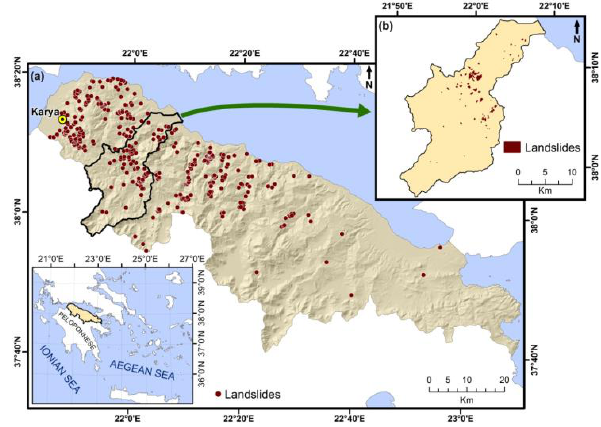
Figure 1. The landslide inventory map ( a ) of systems of catchments for the regional scale analysis, including the location map ( b ) of Selinous catchment for the more detailed scale analysis.